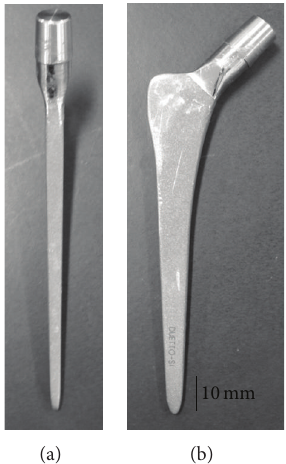
Figure 1: Duetto SI stem with a thin cross-sectional shape. (a) Medial side. (b) Arterial side. The stem surface was processed to produce 6-micron roughness in order to induce bone ongrowth.